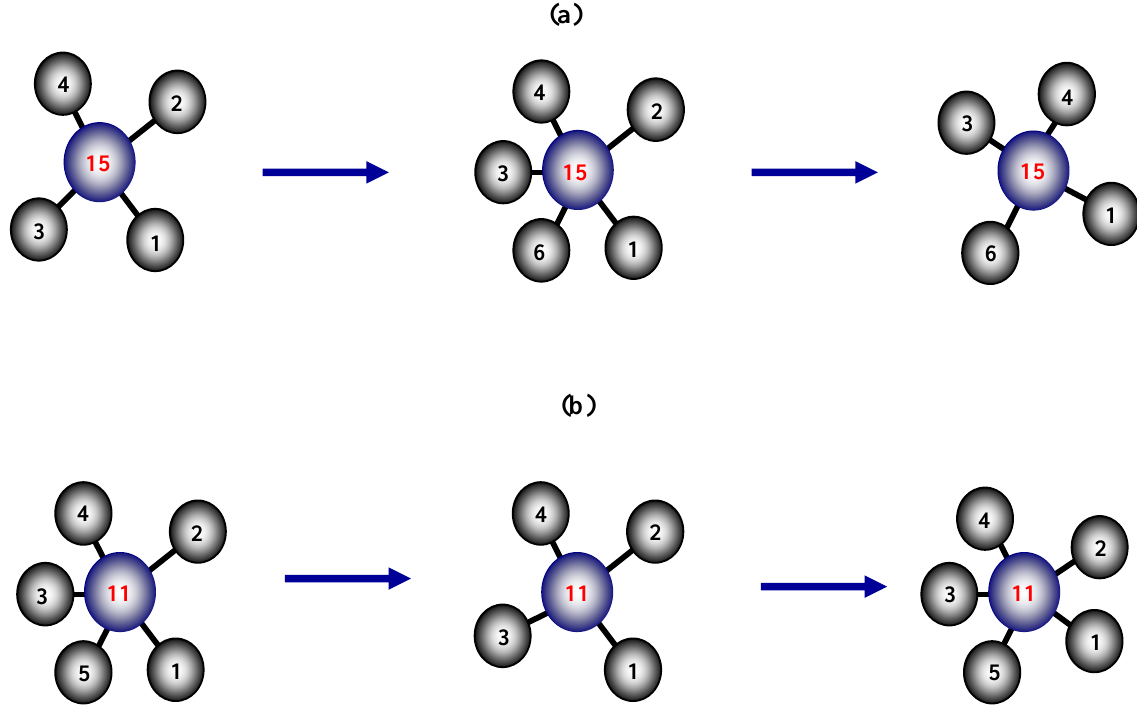
Figure 1. Schematic illustration of two reactions: a) the reactions SiO 4  SiO 5 , SiO 5  SiO 4 happen and the bond Si 12 - O 2 is replaced by Si 12 - O 6 ; b) the reactions SiO 5  SiO 4 , SiO 4  SiO 5 happen and the bond Si 10 - O 5 is broken, then